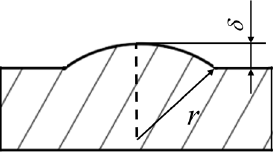
Figure 2. The protrusion structure diagram. Table 2. Thickness of the turning vanes in different model. Table 1. Protrusion structure size of each surface.